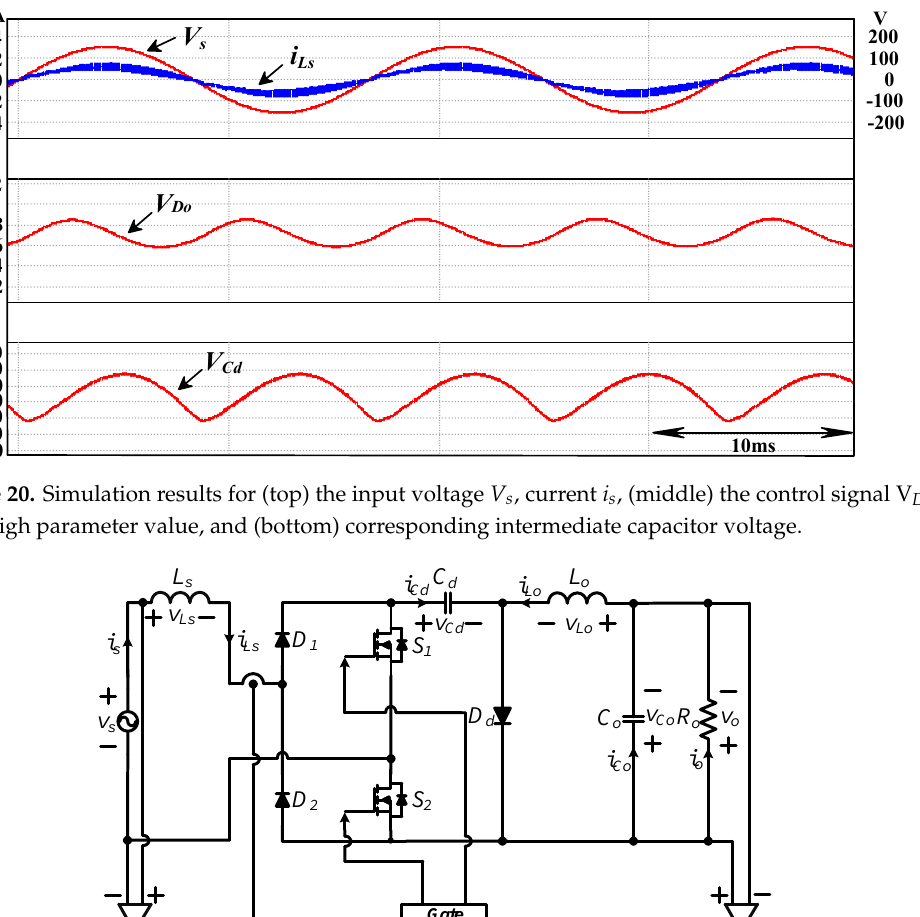
Figure 19. Simulation results for (top) the input voltage V s , current i s , (middle) the control signal V Do with low parameter value, and (bottom) corresponding intermediate capacitor voltage.